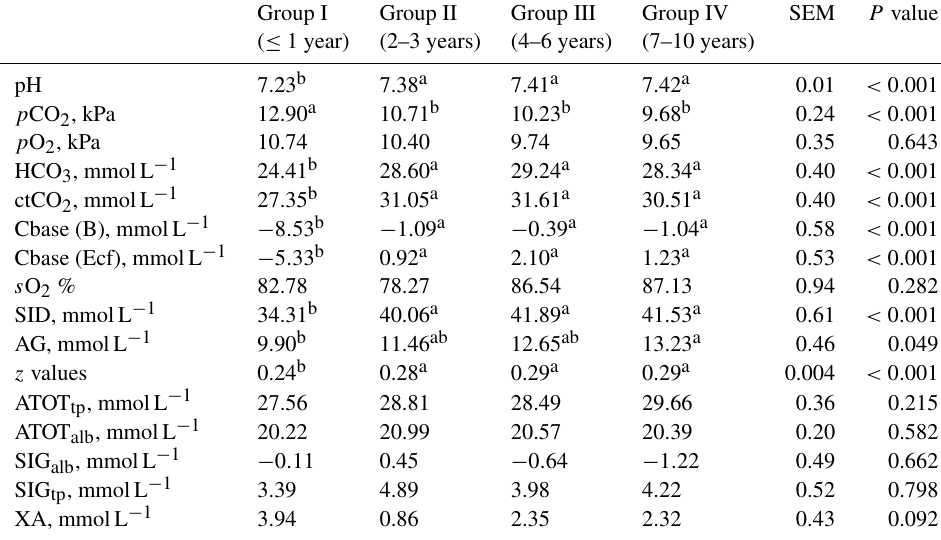
Table 5. Blood acid–base balance from goats of different